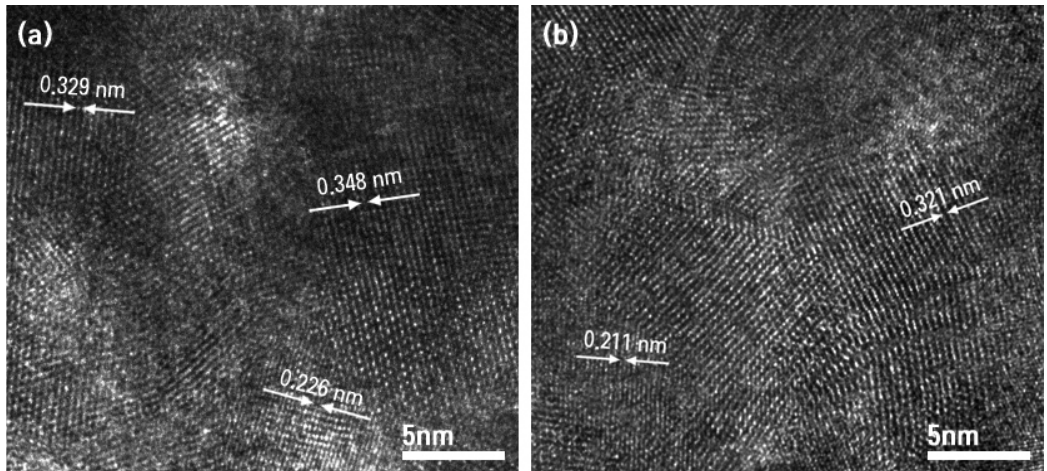
Figure 6. HRTEM images showing the lattice fringes of anatase, rutile and graphene components in S4 (550) ( a ) and S4 (800) ( b ).